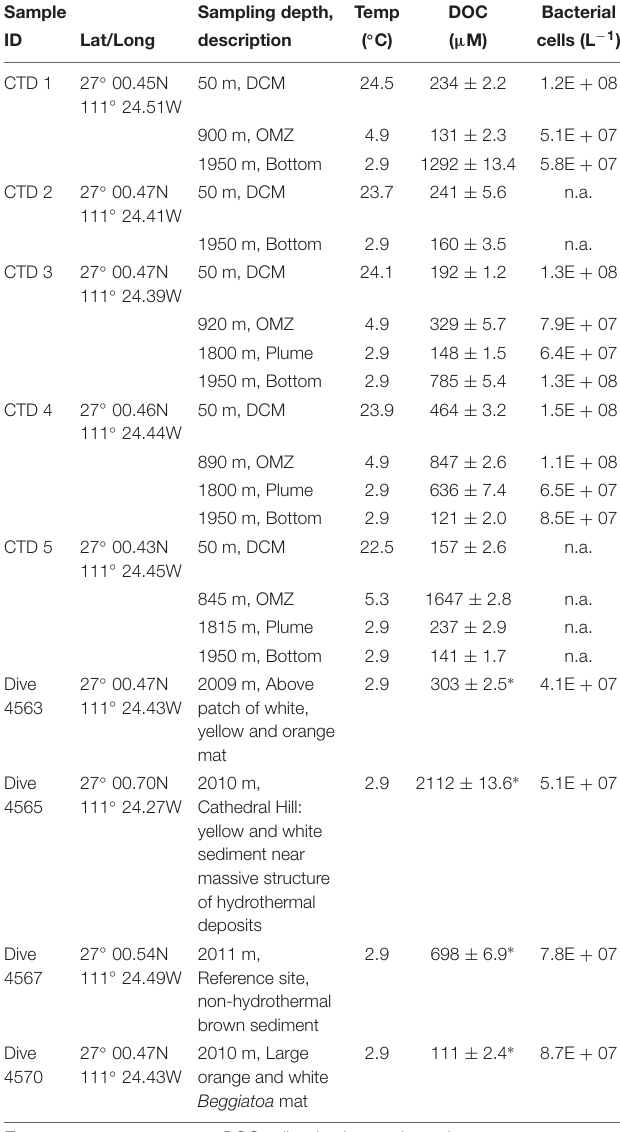
TABLE 1 | Sampling sites and water column